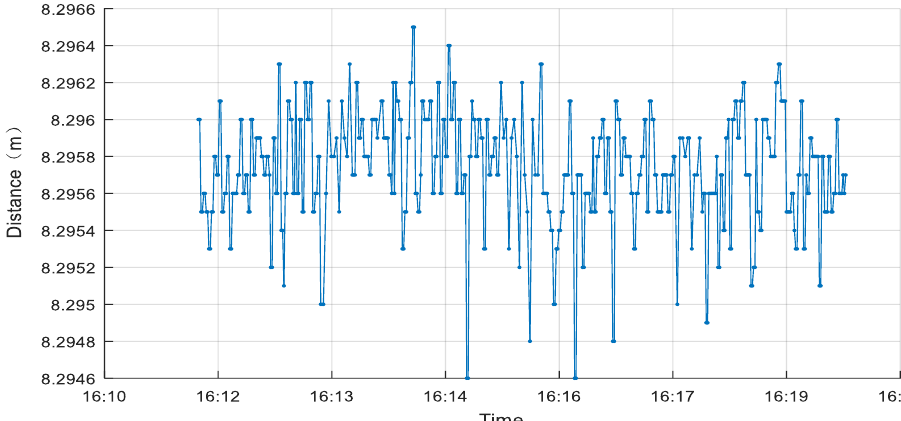
Figure 8. Static ranging test of laser displacement monitoring equipment.